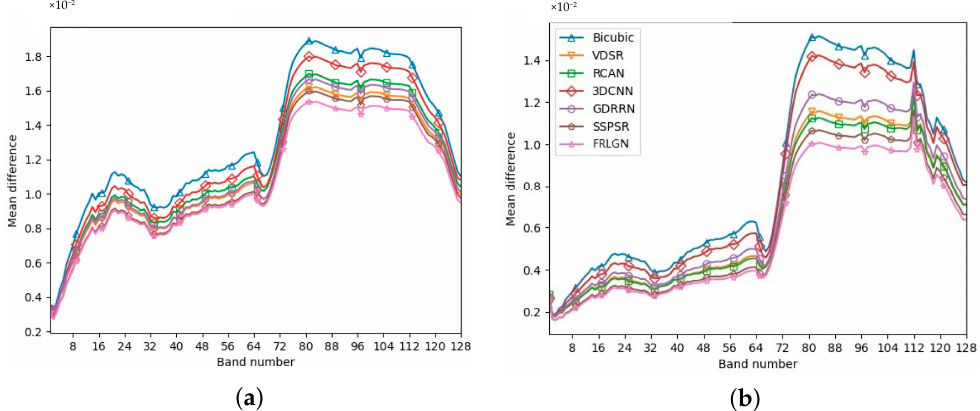
Figure 10. Mean spectral difference curve of two hyperspectral images ( a , b ) from the Chikusei testing dataset with the scale factor